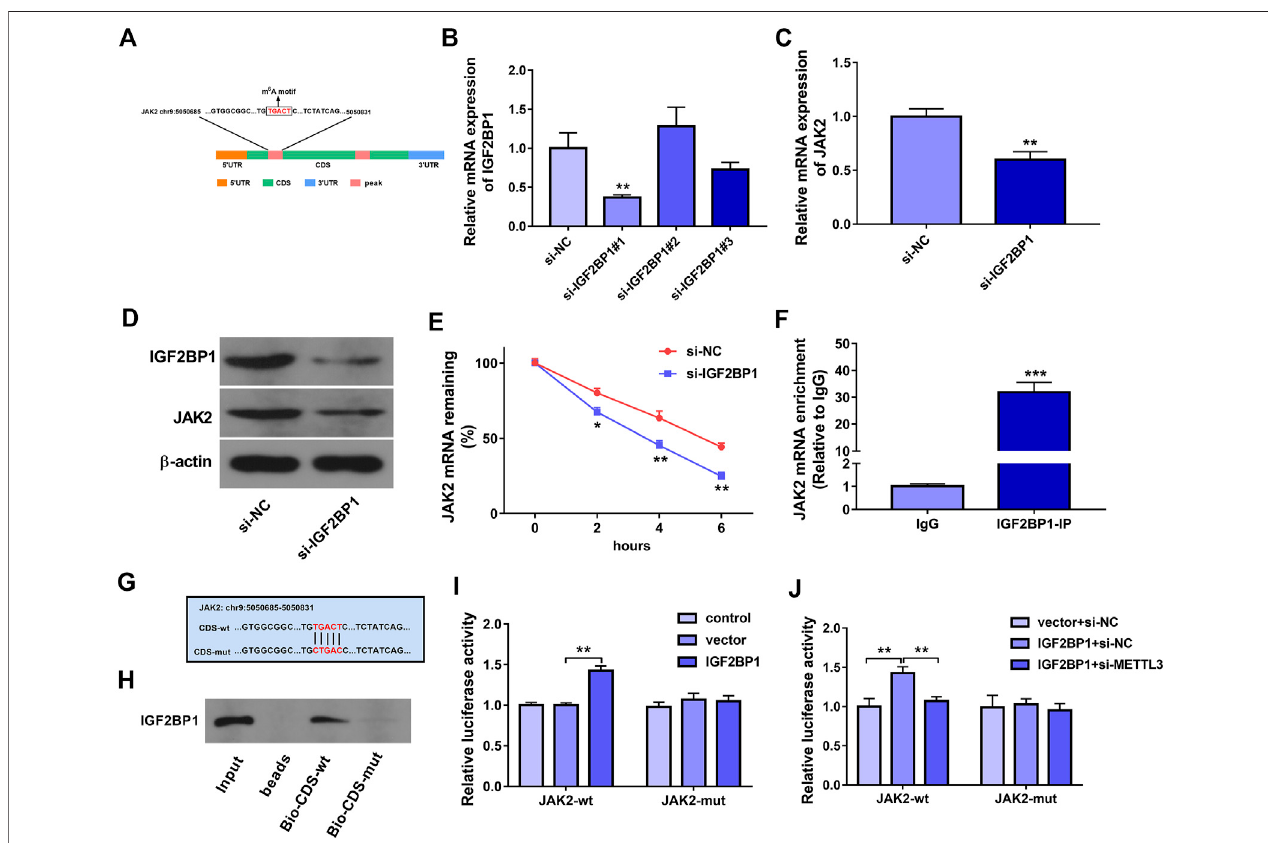
FIGURE 4 | IGF2BP1 positively regulated JAK2 expression and mRNA stability by directly binding to an m6A site within the CDS of JAK2 mRNA, and METTL3 knockdown impaired the interaction of IGF2BP1 and JAK2 mRNA in HUVECs. (A) The location of this m6A methylation motif in JAK2 mRNA. (B) HUVECs were transfected with si-NC, si-IGF2BP1#1, si-IGF2BP1#2, or si-IGF2BP1#3. Forty-eight hours later, IGF2BP1 mRNA level was measured through RT-qPCR assay. (C – E) HUVECs were transfected with si-NC or si-IGF2BP1#1 for 48 h (C) JAK2 mRNA level was measured through RT-qPCR assay. (D) Protein levels of IGF2BP1 and JAK2were measured bywestern blot assay. (E) The stability ofJAK2mRNA wasexaminedby ActDassay. (F) RIPassay wasperformed inHUVECs using theantibody againstIgGorIGF2BP1.JAK2mRNAlevelinIgGorIGF2BP1immunoprecipitationcomplexwasmeasuredbyRT-qPCRassay. (G) Thewildormutantm6Amethylation site in JAK2 mRNA. (H) RNA pull-down assay was conducted in HUVECs using biotin-labeled JAK2 CDS-wt or CDS-mut probe. IGF2BP1 protein level pulled down by biotin-labeled probe was measured through western blot assay. (I, J) Luciferase activities were measured at 48 h after transfection. Three independent experiments were performed for all in vitro assays. * p < 0.05, ** p < 0.01, *** p < 0.001.